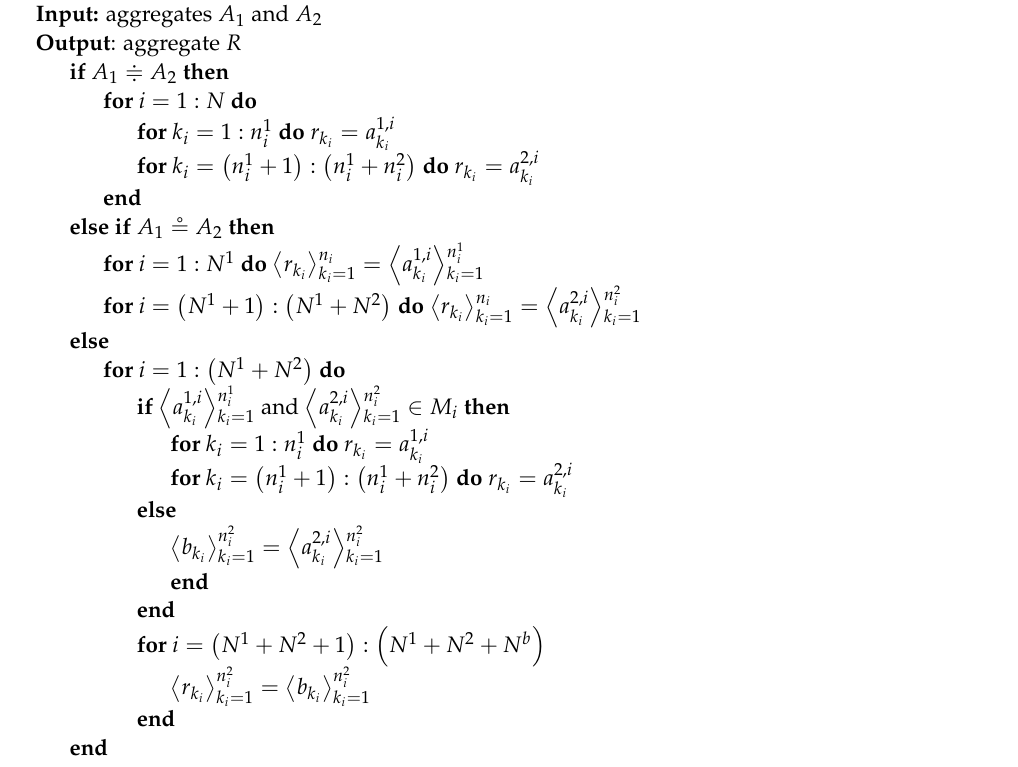
( a ) The given compatible aggregates.